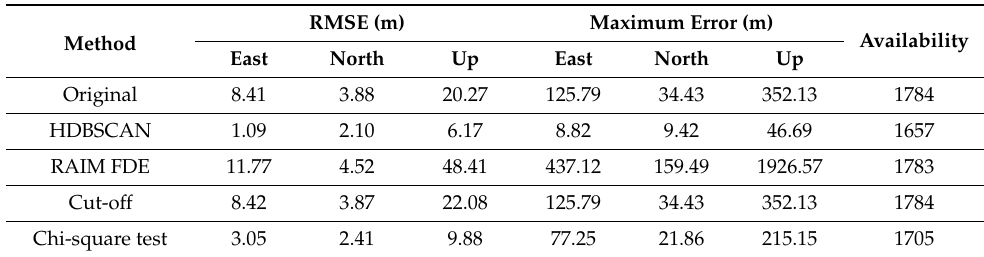
Table 8. Comparison of positioning accuracy and availability of D1 using di ff erent anomaly detection and exclusion